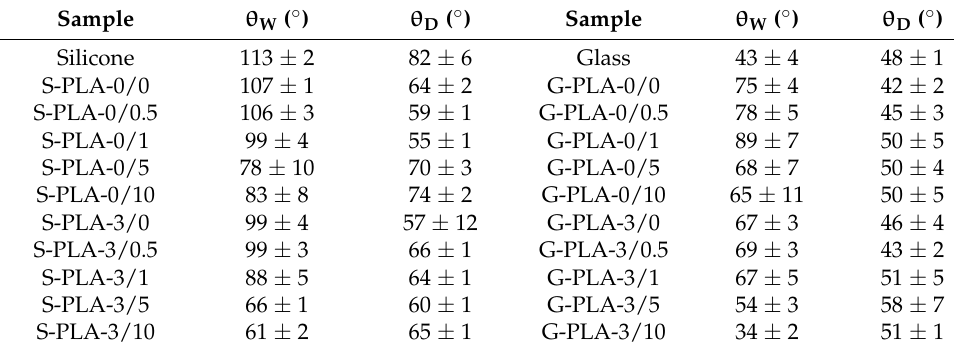
Table 1. Contact angles of water ( θ W ) and diiodomethane ( θ D ) on silicone, glass and the silicone and glass-casted films made of PLA, Mg particles and CTAB at the film-substrate interface. Sample θ W ( ◦